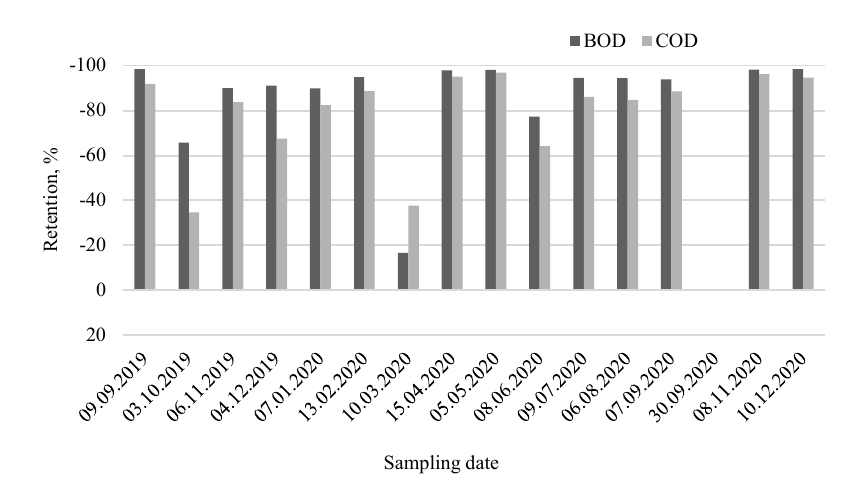
Fig. 7. The retention (%) of BOD 5 and COD of the storm water treatment system with subsurface flow constructed wetland.